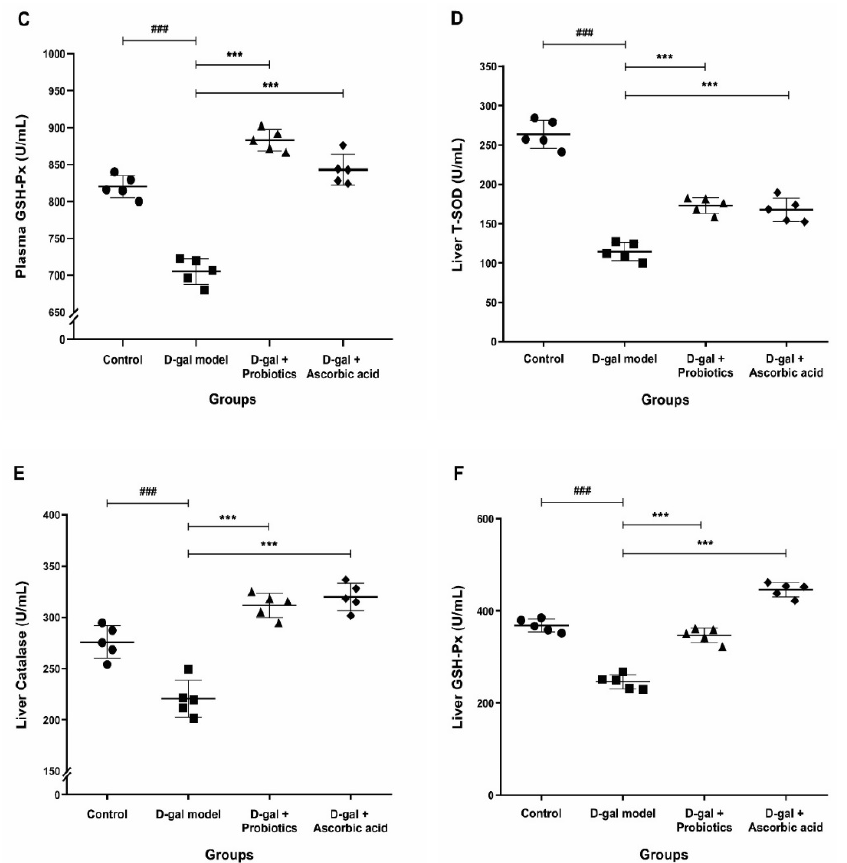
Figure 4. Effect of B. animalis MSMC83 or ascorbic acid on the plasma and liver antioxidant index in oxidative stress rats. Plasma superoxide dismutase; SOD ( A ), plasma catalase ( B ), plasma glutathione peroxidase; GSH ‐ Px ( C ), liver SOD ( D ), liver catalase ( E ), liver GSH ‐ Px ( F ). ● , ■ , ▲ , ◆ as individually in each group. ### p < 0.001 as compared with the control group. *** p < 0.001 as compared with the D ‐ gal model group ( n = 5).